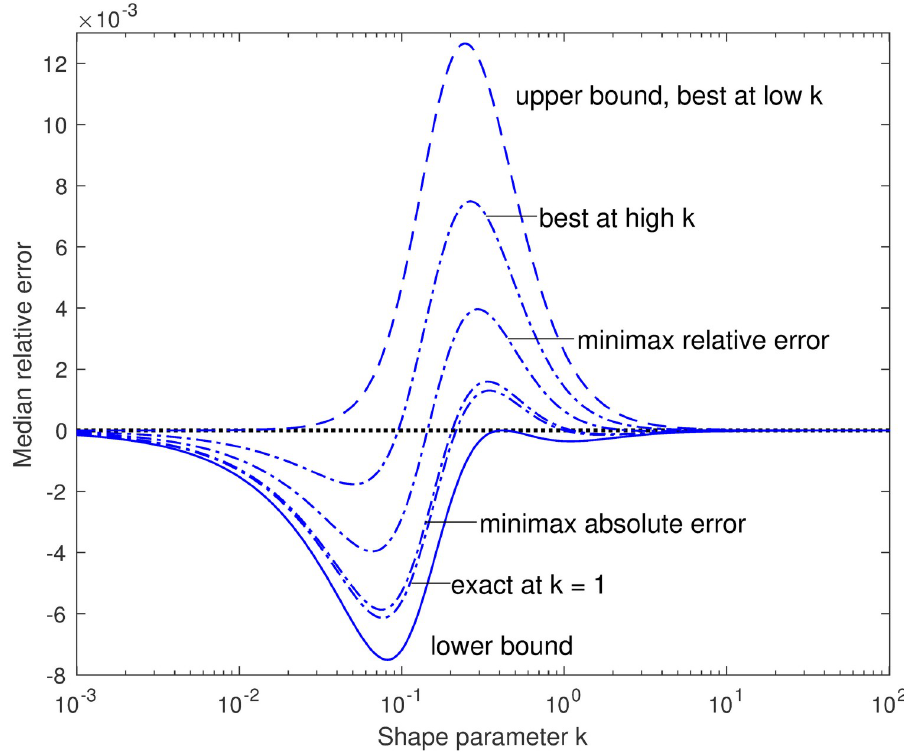
Fig 10. Relative errors of arctan interpolations. Relative errors of arctan-interpolated approximations (dash-dot curves) between the upper (dashed) and lower (solid) bounds. These are among the possibly interesting approximations suggested by the tight-bounds approach. The non-bounding approximations, optimized for different criteria, all have maximum relative errors below 1%.